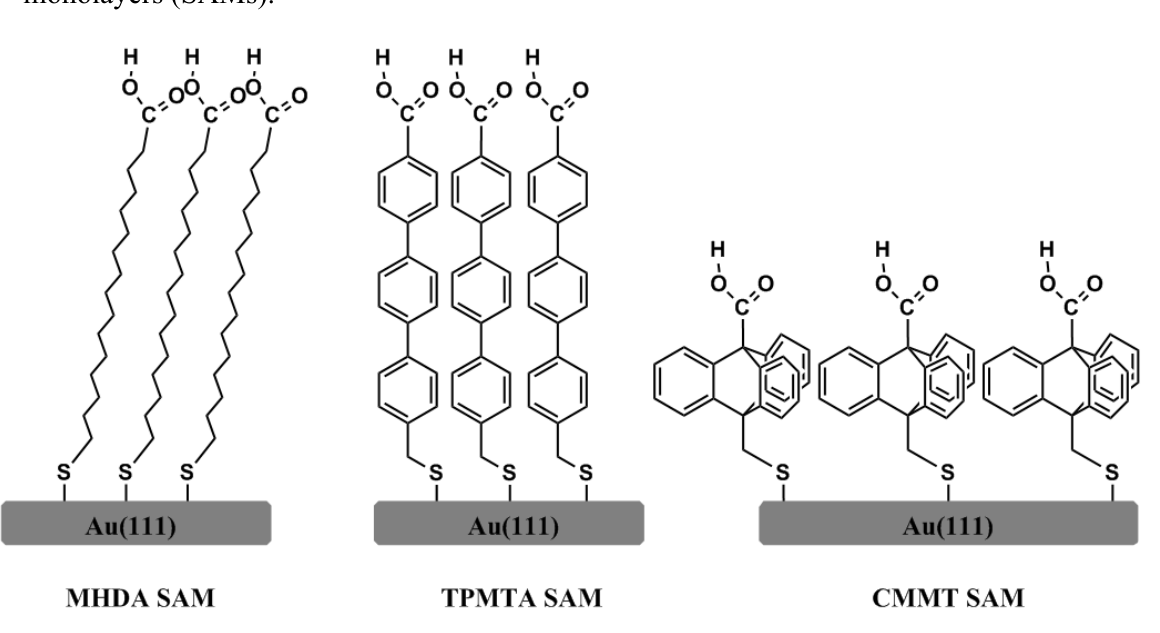
Figure 1. Schematic drawings of various carboxylic groups-terminated self-assembled monolayers